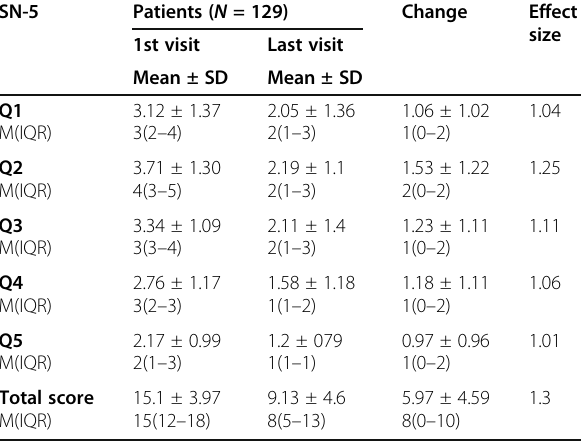
Table 5 Sensitivity to longitudinal change of the SN-5 questionnaire in the 1st and last visits SN-5 Patients ( N =